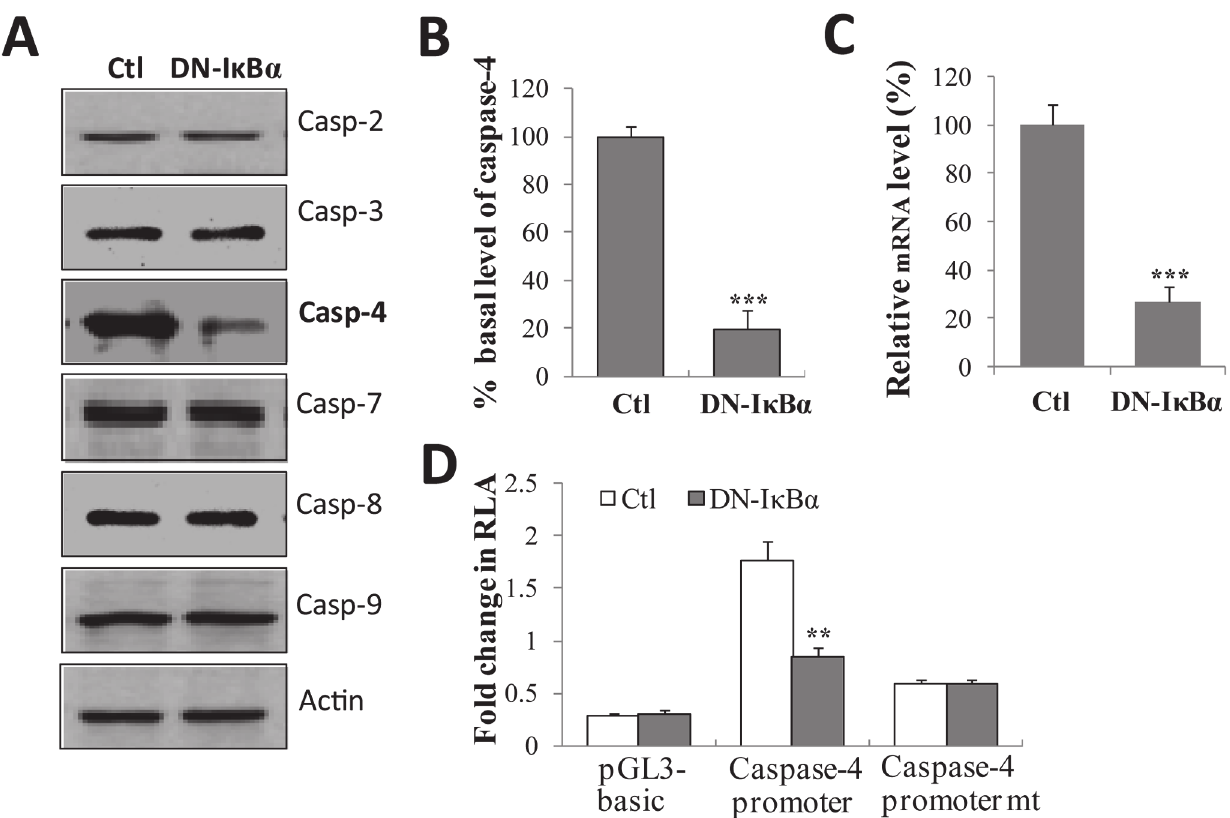
Fig 3. NF- κ B inhibition down-regulates the expression of caspase-4. ( A ) SH-EP1 cells transfected with control vector (Ctl) or DN-I κ B α expression vector (DN-I κ B α ) were lysed, and the expression levels of various caspases were detected using corresponding antibodies. ( B ) The expression level of caspase-4 was quantified. The caspase-4 level of DN-I κ B α cells is expressed as a percentage of the level measured in control SH-EP1 cells. ( C ) The relative mRNA levels of caspase-4 in DN-I κ B α cells were determined by qPCR. ( D ) The dual luciferase reporter assay was performed to evaluate the effect of DN-I κ B α on caspase-4 promoter activity. DN-I κ B α could significantly induce the activity of caspase-4 promoter, NF- κ B binding site, but not NF- κ B binding site mutant (mt). RLA represents relative luciferase activity. Data are representative of three independent experiments and shown as average ± s.e.m. (bars) values. ** P < 0.01 and *** P <